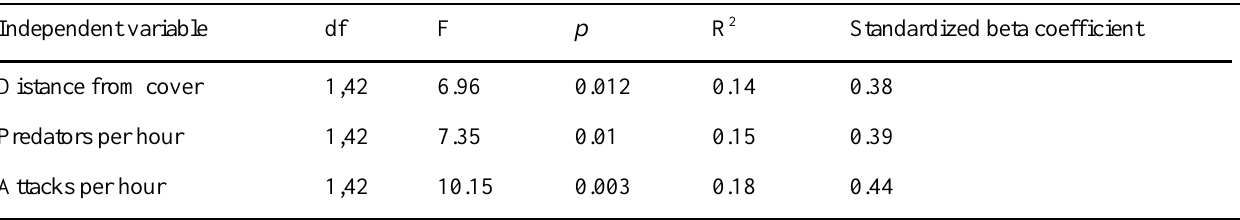
Table 5. Results of regressions for factors predicting habitat use by sandpipers roosting at high tide. Note that none of these variables could be combined into a single model because of problems of multicollinearity.